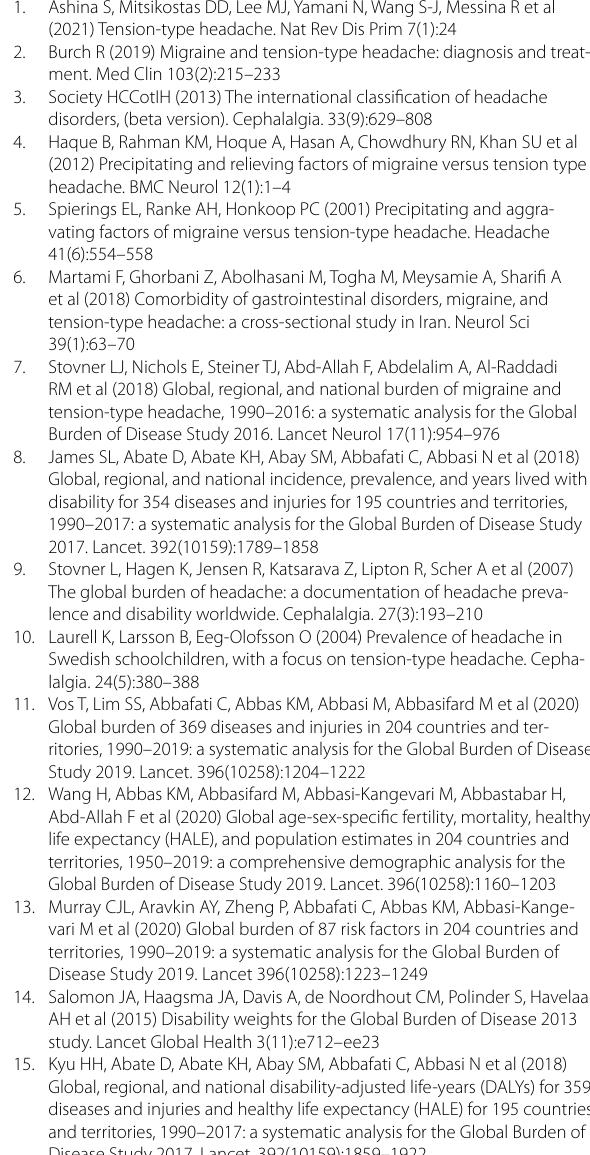
Table S3. YLDs due to tension‑type headache in 1990 and 2019 for both sexes and the percentage change in the age‑standardised rates (ASRs) per 100000 in the Middle East and North Africa region (Generated from data available from http:// ghdx. healt hdata. org/ gbd‑ resul ts‑ tool). Figure S1. The percentage change in the age‑standardised point prevalence of tension‑ type headache in the Middle East and North Africa region from 1990 to 2019, by sex and country. (Generated from data available from http:// ghdx. healt hdata. org/ gbd‑ resul ts‑ tool). Figure S2. The percentage change in the age‑standardised incidence of tension‑type headache in the Middle East and North Africa region from 1990 to 2019, by sex and country. (Generated from data available from http:// ghdx. healt hdata. org/ gbd‑ resul ts‑ tool). Fig- ure S3. The percentage change in the age‑standardised YLDs of tension‑ type headache in the Middle East and North Africa region from 1990 to 2019, by sex and country.